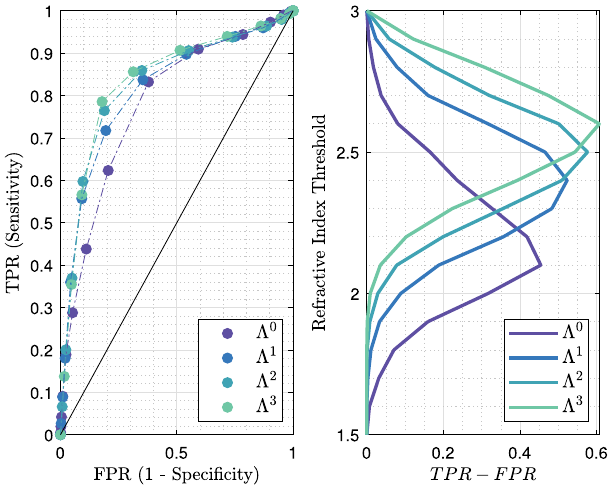
Figure 8. Left: receiver operating characteristic for the different classification methods, at 550-GHz applied to TS#1. The black line stands for TPR = FPR . Right: refractive index threshold as a function of the TPR − FPR measure for the different classifiers.